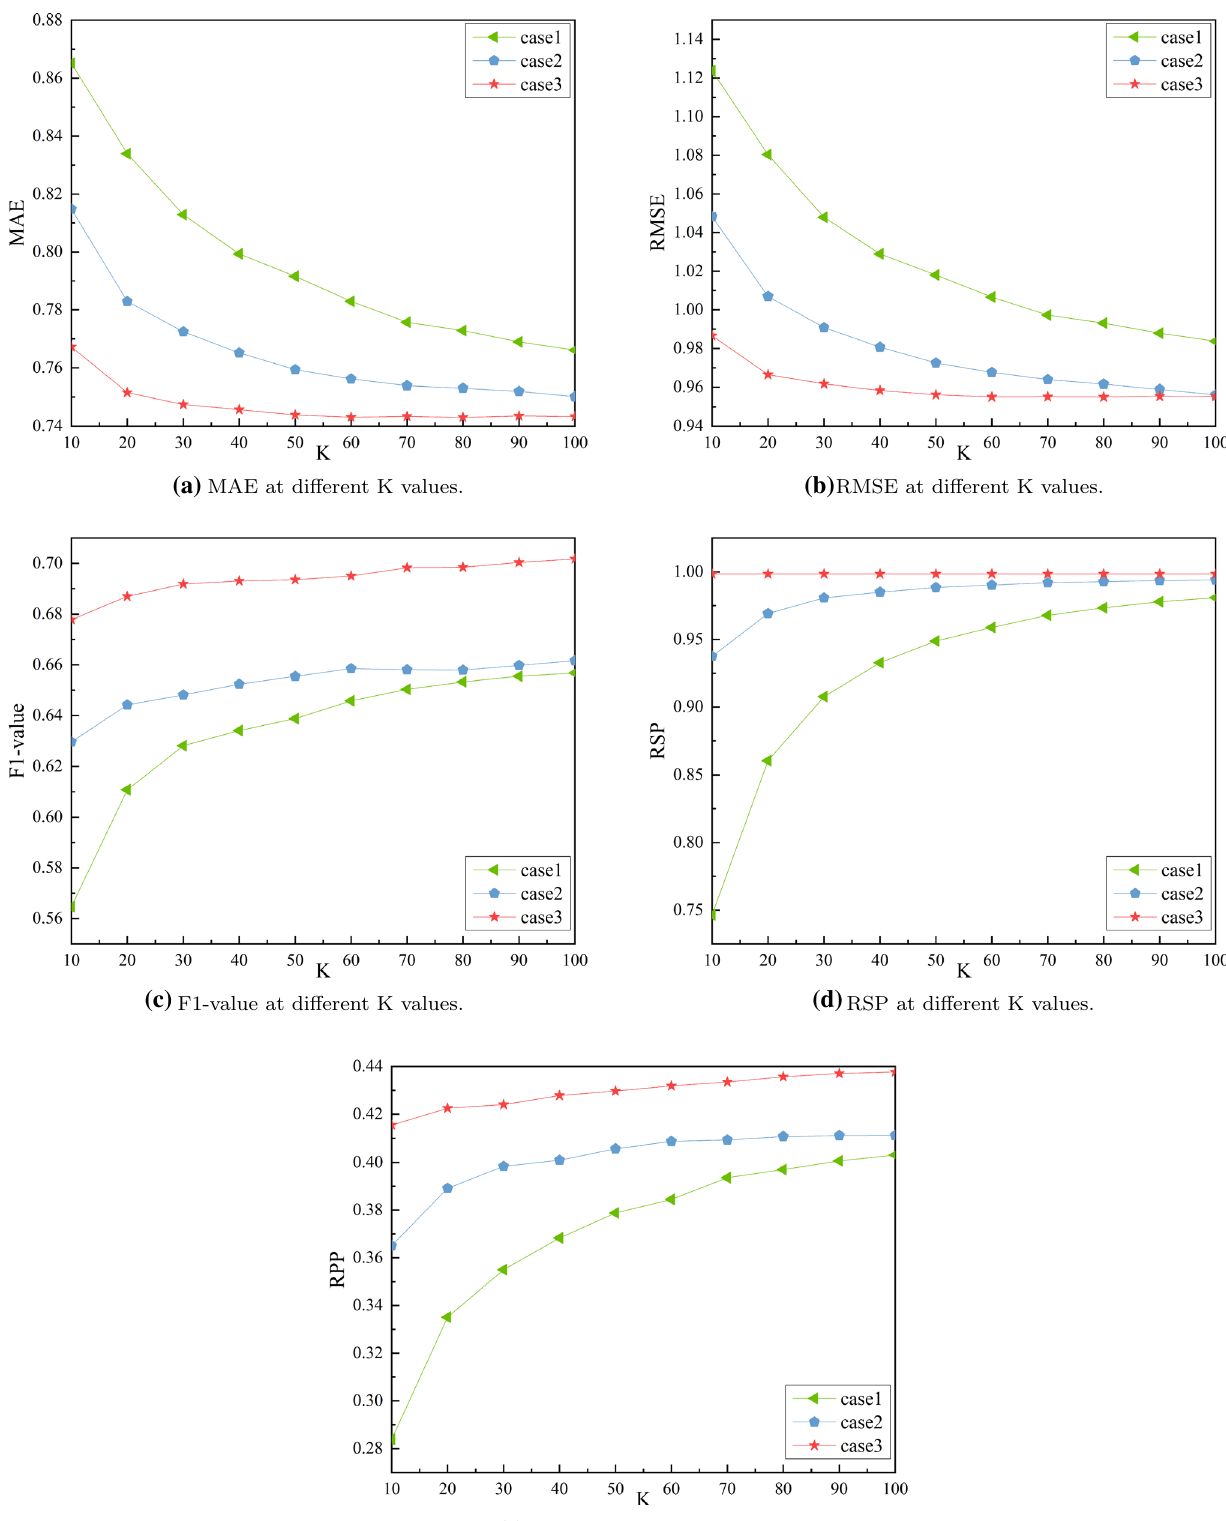
Fig. 1 Performance results in